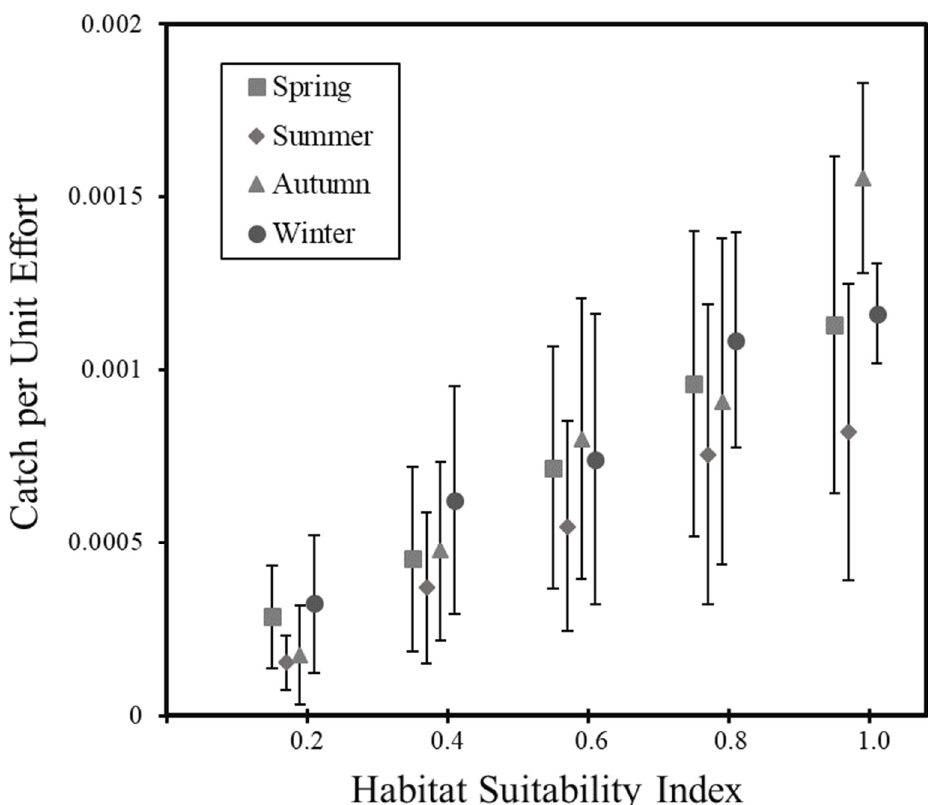
Figure 7. Relationships between the seasonal habitat suitability index (his) values estimated through the MaxEnt habitat model and average CPUE for the range of HSI (0.2 interval).